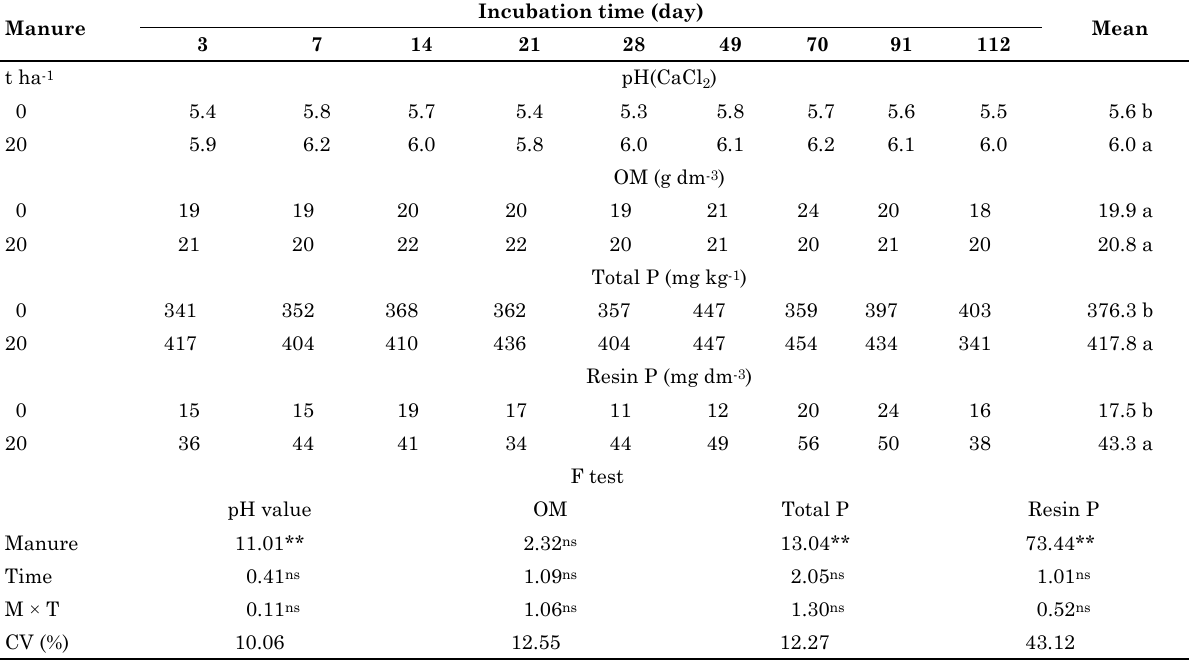
Table 2. Mean values of pH(CaCl 2 ), organic matter (OM), total P and resin P concentrations in a sandy- clay loam Haplustox fertilized or not with cattle manure during increasing periods of